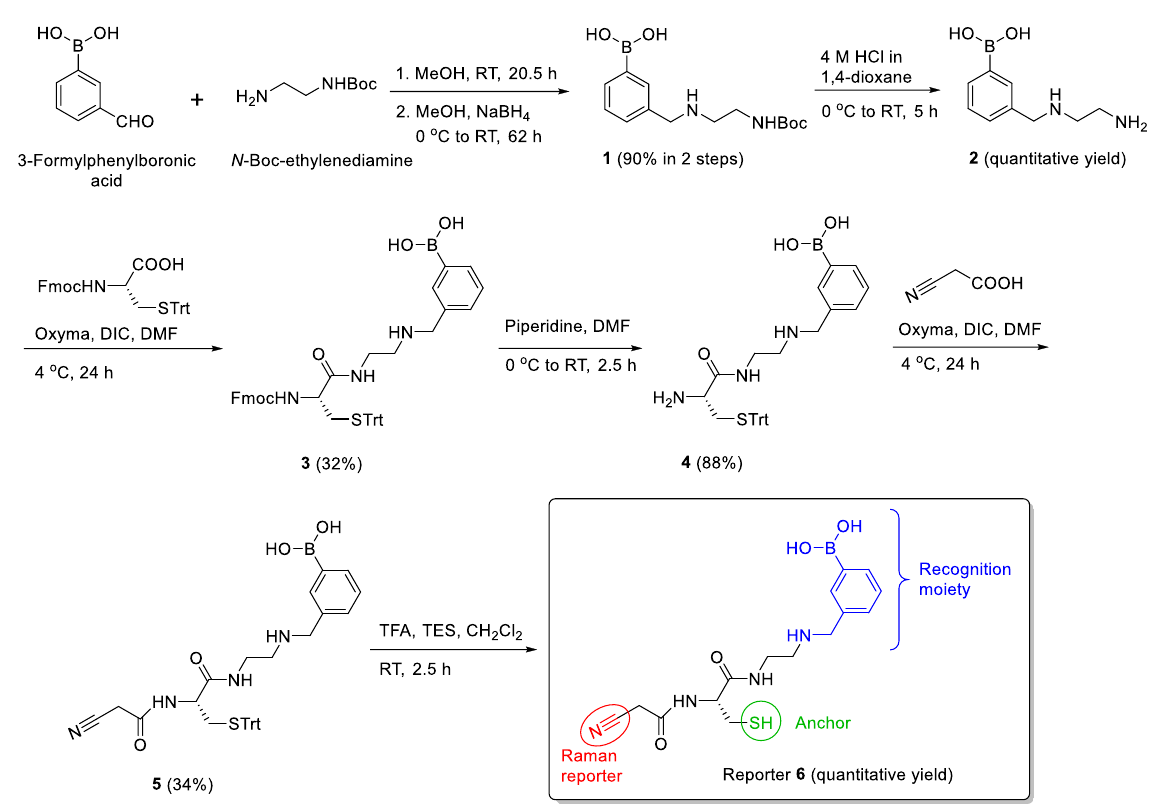
9 of 16 Figure 2. Characterizations of the synthesized tri-functional nanoprobe (reporter 6 -conjugated AgNCs) by ( a ) hydrody- namic size, ( b ) zeta potential, and ( c ) SERS measurement (at λ = 532 nm, 0.78 mW, 100× objective lens, exposure time of 5